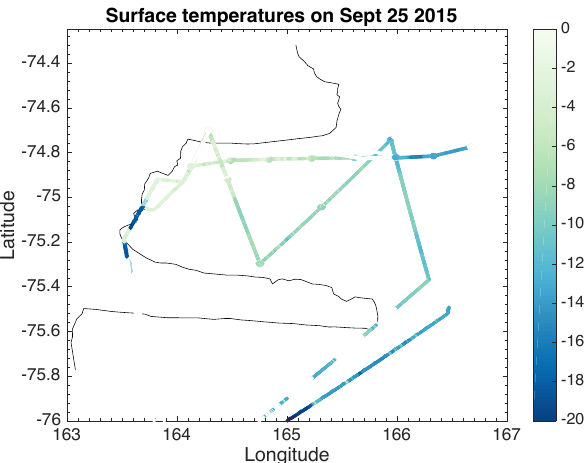
Figure 7. Surface temperature data for the two flights on 25 September 2012 (AV 230 and AV242), plotted over the outline of the polynya area (black